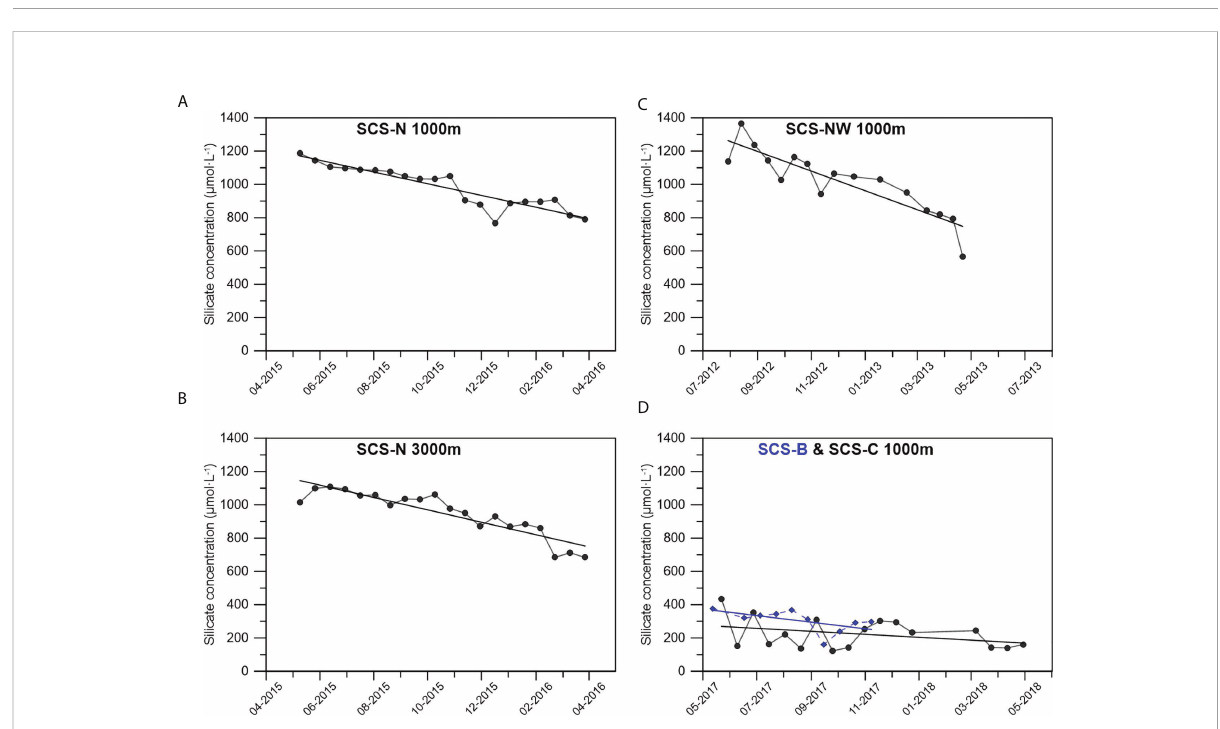
FIGURE 2 Silicate concentration in the supernatant of the sediment trap sampling bottles at 1000 m of stationSCS-N (A) , 3000 m of station SCS-N (B) , 1000 m of station SCS-NW (C) and 1000 m of station B & C with the blueish diamonds representing the data of SCS-B (D)